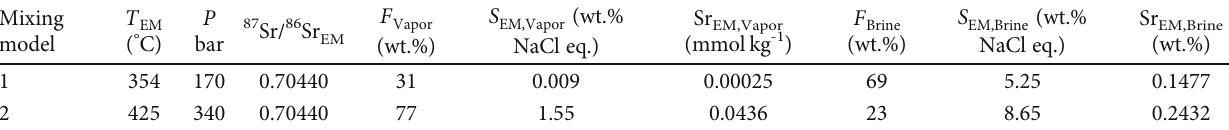
Table 4: Characteristics of coexisting hydrothermal end-member vapor-brine pairs used in our best- fi t isenthalpic mixing model. Temperature, pressure, and salinities ( S , S in wt.% NaCl eq.) were derived from the L+V surface of the H Em,Vapor Em,Brine [57]. F and F (mass fractions in the corresponding vapor and brine pairs) were calculated by the lever rule and by assuming a Vapor Brine source fl uid with seawater salinity. The Sr concentrations (mmol kg -1 ) of the vapor-brine pairs were calculated by assuming Sr partitioning behavior identical to that of salt and using a seawater Sr concentration of 0.09mmolkg -1 ; the 87 Sr/ 86 Sr value of 0.7044 ( 0 : 70437 ± 15 ) for the hydrothermal end-member was derived from 10 hydrothermal fl uid samples by back calculating to Mg = 0 mmolkg − 1